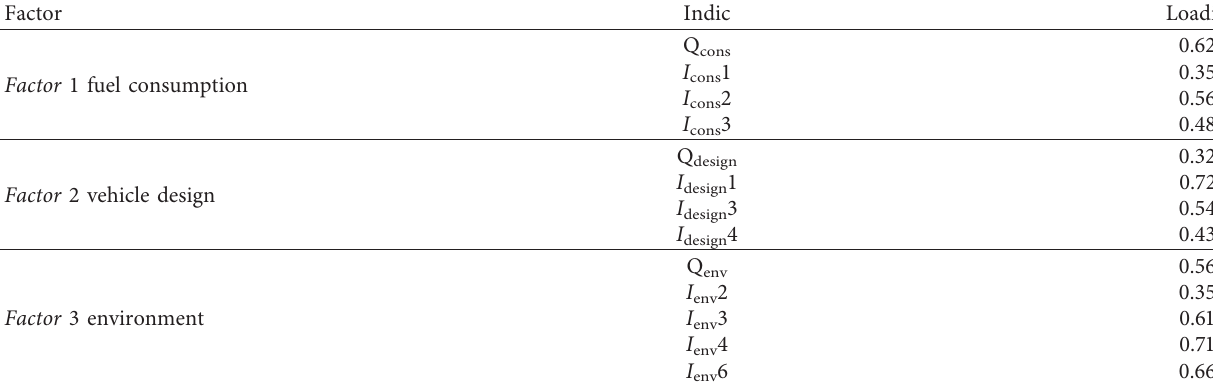
Table 6: Principal component analysis.